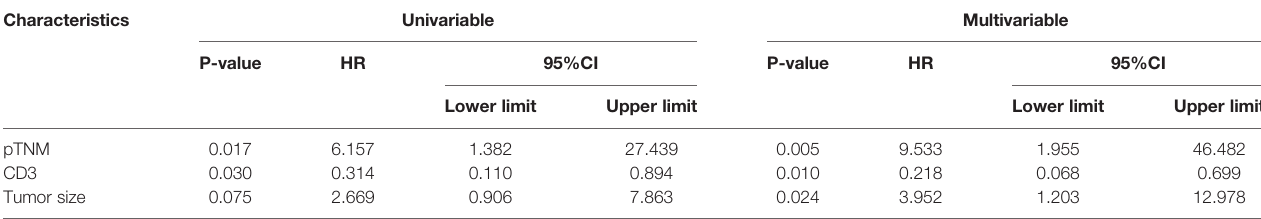
TABLE 3 | Univariable and multivariable survival analysis of EBVaGC cases.